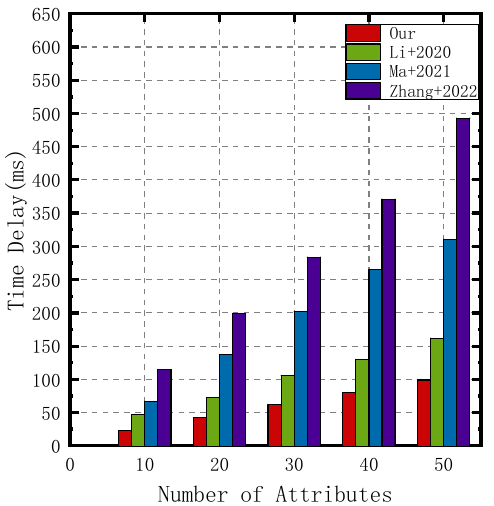
Figure 5. Cost of key generation [23–25].